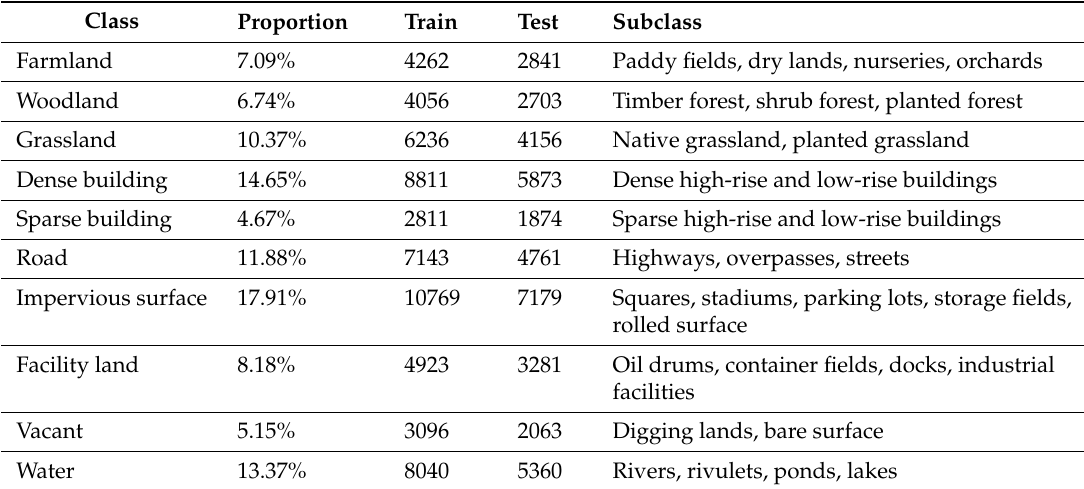
Table 3. Land-cover classes, sample numbers, and subclass descriptions in the Beilun dataset. Class